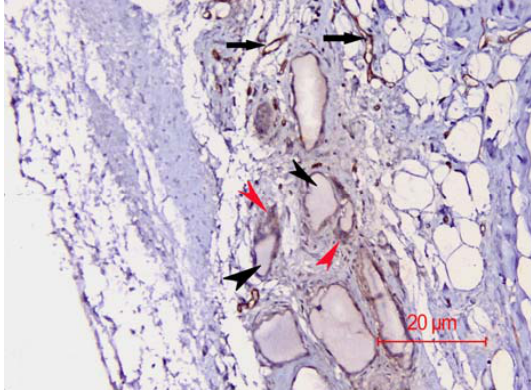
Figure 9. CD31 immunohistochemical staining of the implant. Black arrowheads mark the vascular structures, black arrows mark the CD31 ‐ positive cells delineating the vascular structures. Red arrowheads mark the osteoclasts at the interface between the implant and bone. The magnification is 100×.